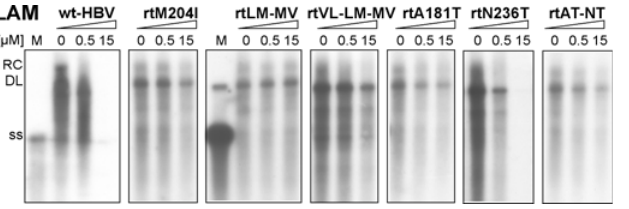
Fig 2. Semiquantitative assessment of LAM resistance by Southern blotting. Cells producing the indicated viruses grown in the absence of DOX were treated, or not, with 0.5 μ M or 15 μ M LAM. Intracellular viral DNAs were analyzed as in Fig 1A, except that a heat-denatured 3.2 kb HBV restriction fragment served as marker for ss DNA (strong signal) and DL DNA (weak signal). Note the nearly complete loss of signal at 15 μ M drug for the wt-HBV and rtN236T lines, but not the cell lines encoding viruses with established LAM resistance-associated mutations. EC 50 values for all cell lines are provided in Table